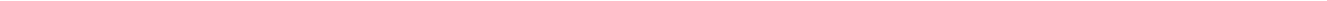
Fig. 3 Variance adaptation and courtship song signals. a Courtship song is produced in bouts and consists of two modes: sine (blue) and pulse (red). b Sine song (blue) exhibits a relatively constant amplitude pro fi le, while pulse song (red) consists of trains of transient pulses with interleaved pauses. c , d Arti fi cial sine song and pulse song presented at a range of different intensities (color coded, see legend in e ). e CAP (top — raw CAP, bottom — CAP amplitude) from one fl y for 300 Hz sinusoids of different intensities ( c ). Intensity is color coded (see legend). After a strong onset transient (left), the CAP amplitude drops rapidly (right — steady-state response after 500 ms). Inset shows the frequency doubling of the CAP (top — stimulus at 4 mm s − 1 , bottom — CAP response oscillates at twice the stimulus frequency, or 600 Hz). f CAP (top — raw CAP, bottom — CAP amplitude) from one fl y for synthetic pulse trains with different intensities ( d pulse interval 36 ms, intensity color coded, see legend in e ). While there is a weak decrease of response amplitude across pulses in a train, responses still scale with intensity (see also Supplementary Fig. 8c – e). g , h Onset and steady-state intensity tuning for sine stimuli ( g ) and pulse stimuli ( h ) (see also Supplementary Fig. 8); N = 6 fl ies, 20 trials each. Error bars correspond to mean ± 95% CI across fl ies. i Asymmetrical responses to pulses (inset — CAP from one fl y) betray adaptation. Thin black lines show CAP amplitude vs. stimulus amplitude for the fi rst six pulses in a train (pulse peak intensity 2 mm s − 1 ). N = 6 fl ies. Responses to pulse onset have a much larger slope than those to pulse offset (see diagonal lines). j Peak responses at steady state (after 1.4 s into pulse train) for pulse trains with different inter-pulse intervals (pulse duration 16 ms, intensity 4 mm s − 1 , gray lines show response of individual fl ies ( N = 4), normalized to the max response; thick black lines correspond to mean ± s.e.m.). Responses are weak for short inter- pulse intervals due to stronger adaptation. Inset shows CAP amplitude traces for pulse trains with IPIs of 8 ms (blue), 24 ms (red) and 72 ms (orange).